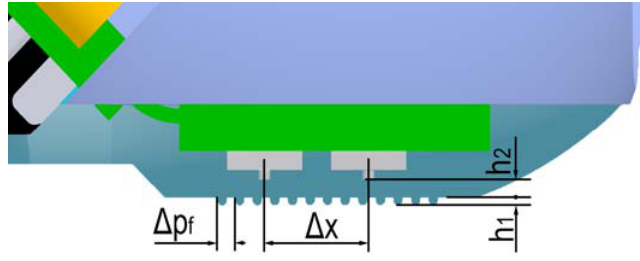
Figure 2. Cross section of the biomimetic fingertip, showing two sensors of the array and the structure and dimensions of fingerprints. The array pitch Δ X is 2.36 mm, the fingerprints have between-ridge distance Δ p set to 400 µ m, while their thickness h f of the homogeneous packaging layer covering the sensor array is 600 µ thickness h 2